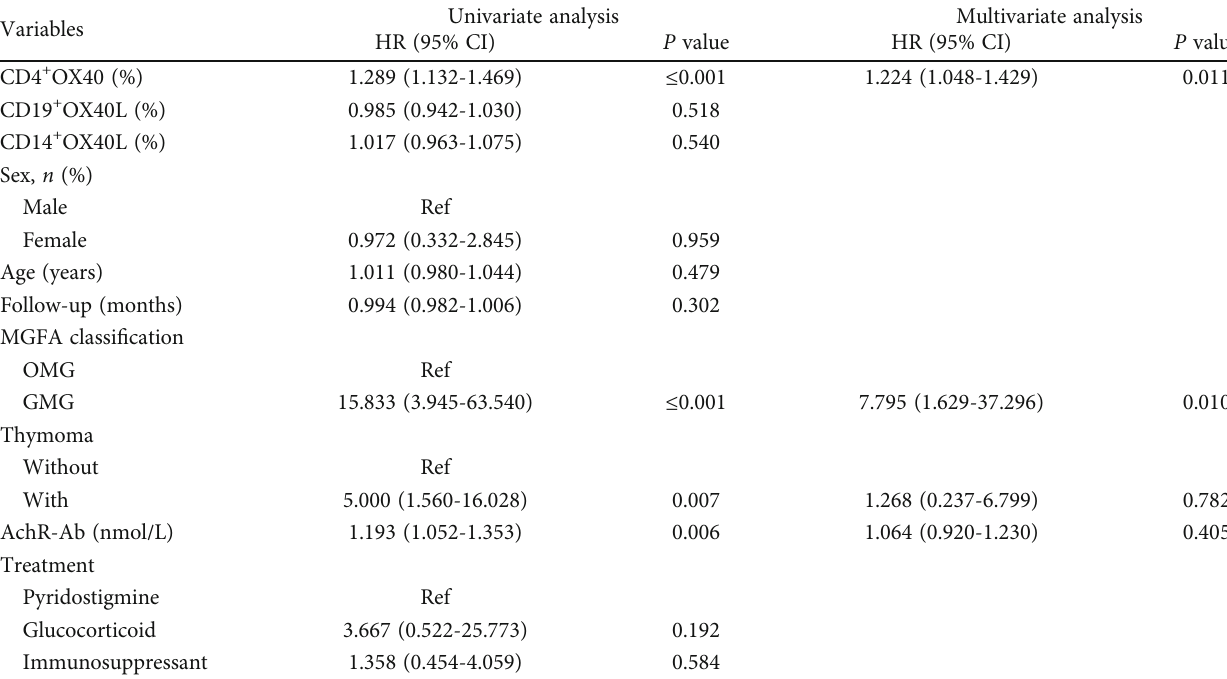
Table 7: Univariate and multivariate logistic regression risk models of the risk of relapse of MG (membrane-bound molecules). Variables